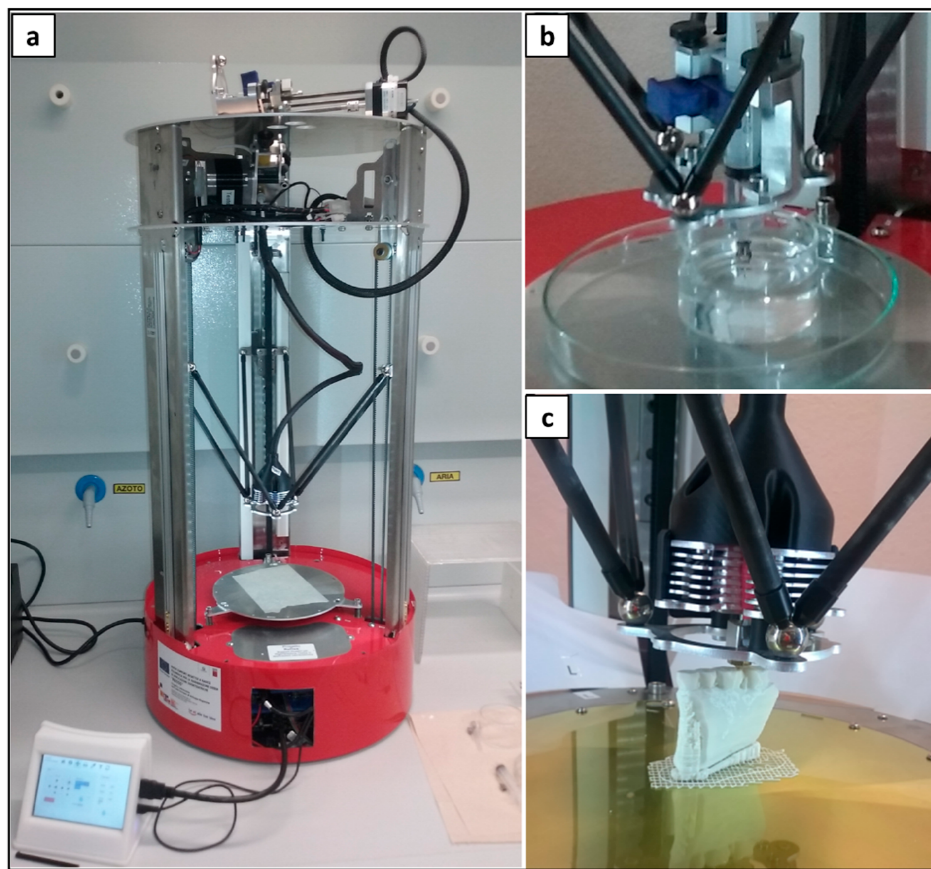
Figure 2. AM system with switchable extrusion heads: representative pictures of ( a ) the machine wired to the local touch screen control unit, ( b ) melt-extrusion head, and ( c ) solution-extrusion head. Samples fabrication was carried out by employing optimized processing parameters in terms of infill angle, infill density, layer height (d z ), infill speed, extruder T, and bed T. Anatomical and dog-bone shape samples were fabricated by processing customized digital models and G-code files. After printing, the samples were collected and stored in a desiccator before